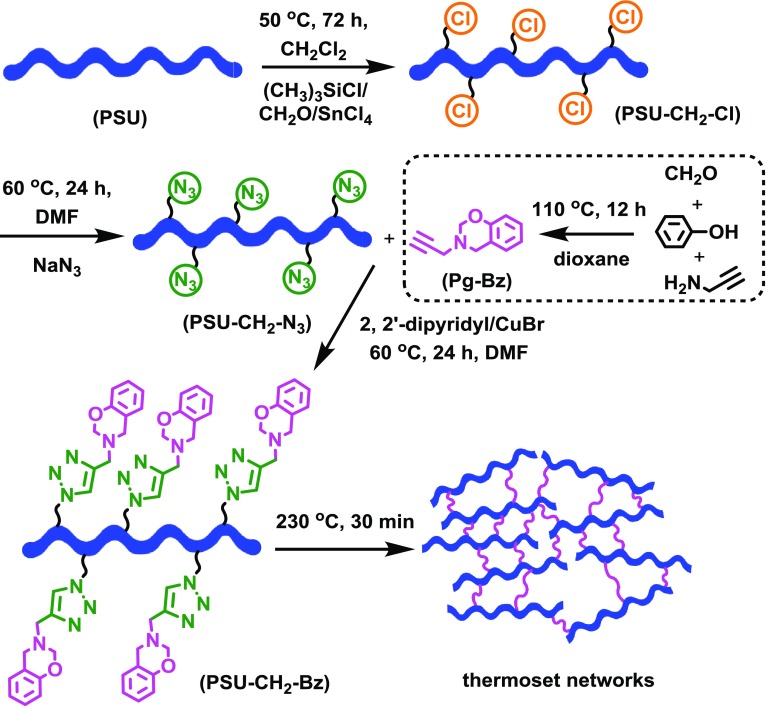
Synthetic route for the PSU-CH2-Bz and its components (PSU-CH2-Cl, PSU-CH2-N3 and Pg-Bz).